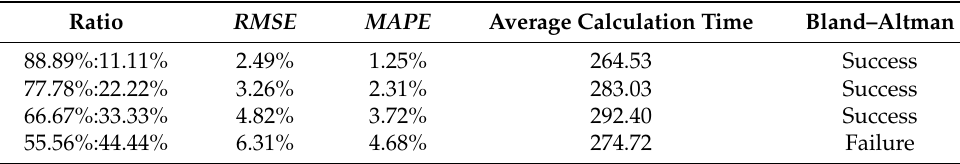
Table 13. Calculation results of the different ratio of training sets to test sets.